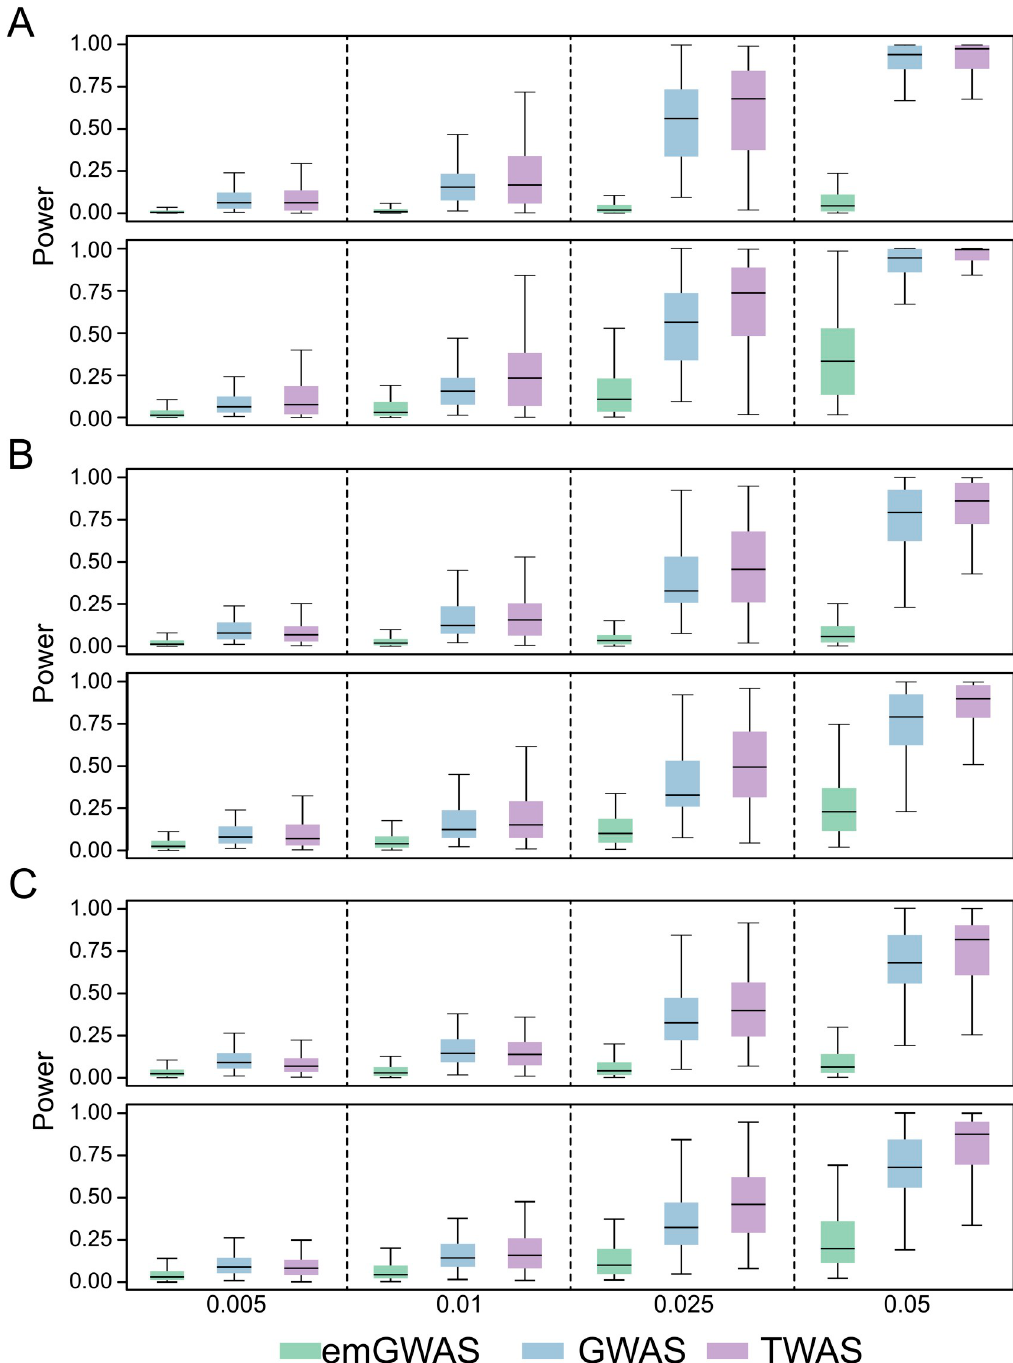
Fig 4. Pleiotropy scenario when expression heritability is high and trait heritability is low. The trait heritability is 0.005, 0.01, 0.025, and 0.05 in the four columns as indicated by the X-axis labels. The numbers of genes contributing to phenotype for (A), (B) and (C) are 4, 9, and 13 respectively. The expression heritability for the top and bottom rows of (A), (B) and (C) are 0.1 and 0.3 respectively. The number of causal variants per gene is randomly sampled from the interval [4,9].